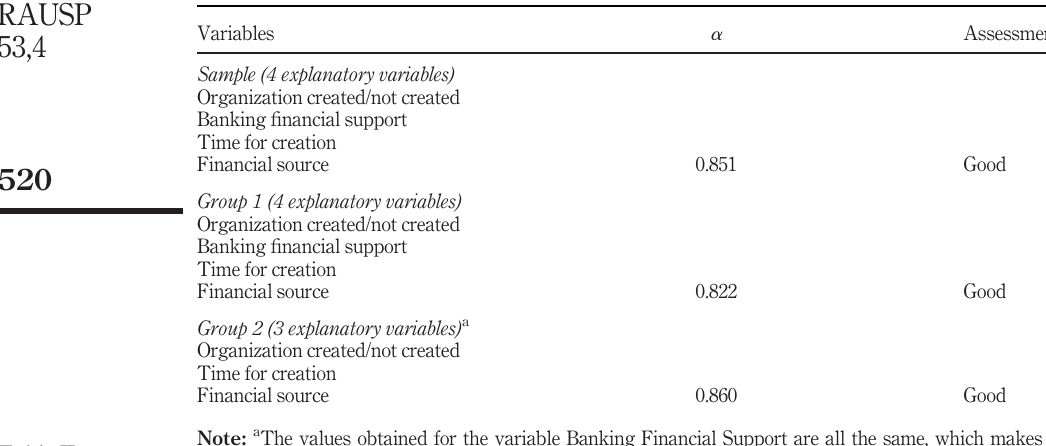
Table II. Cronbach ’ s alpha